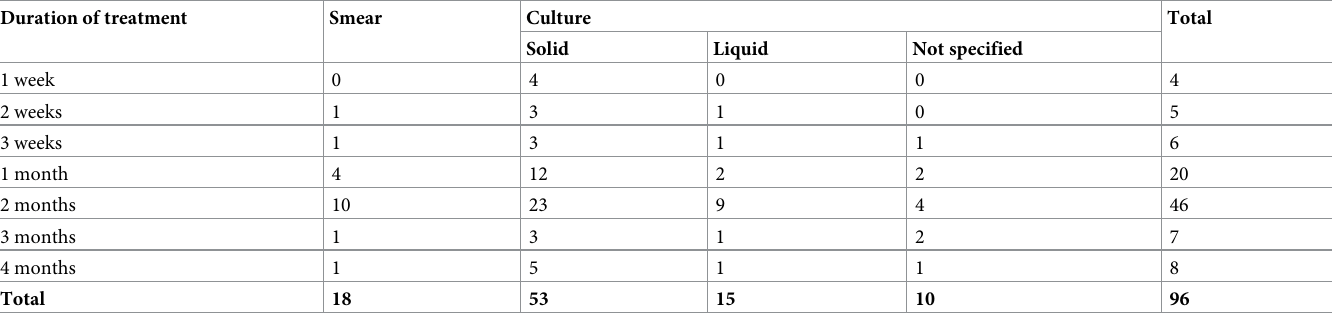
Table 3. Number of estimates contributing to proportion converted analysis by time point and microbiological assessment method.